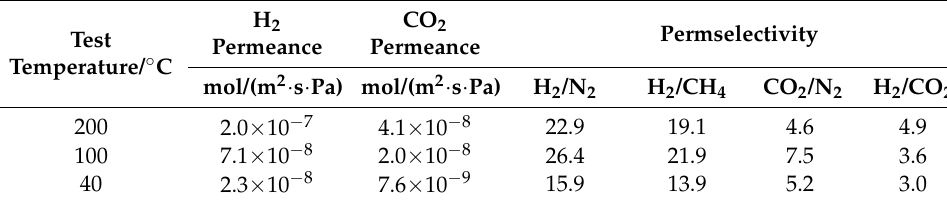
Table 3. Gas permeance and related permselectivity of BTESE-PNEN-0.2 membrane.